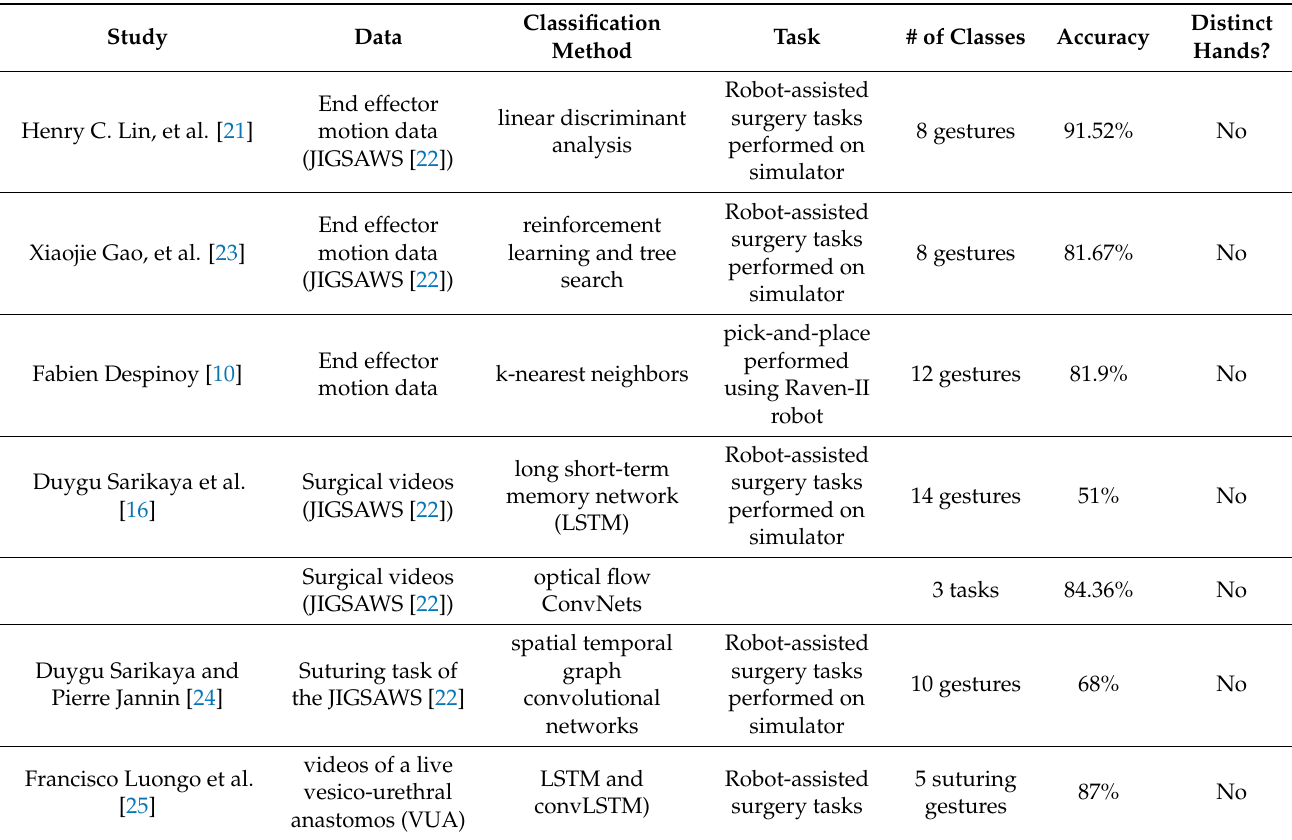
Table 1. Comparing our proposed method with other robot-assisted surgery (RAS) gesture classification